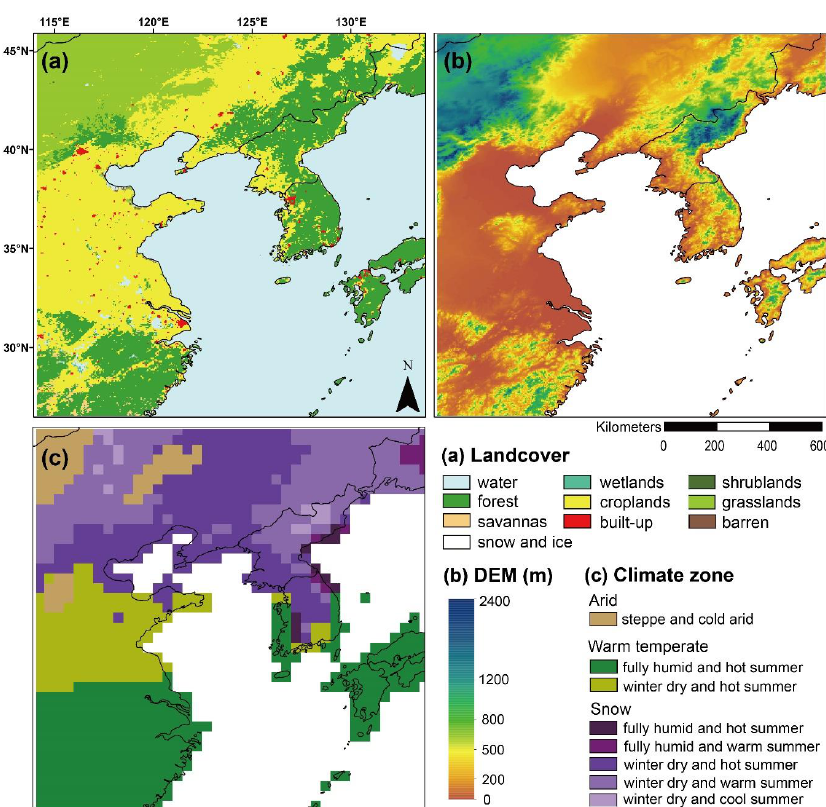
Figure 1. The study area of this research with ( a ) Moderate Resolution Imaging Spectroradiometer (MODIS) landcover, ( b ) Shuttle Radar Topography Mission (SRTM), digital elevation model (DEM), and ( c ) climate classification map (Kottek et al. [42]).